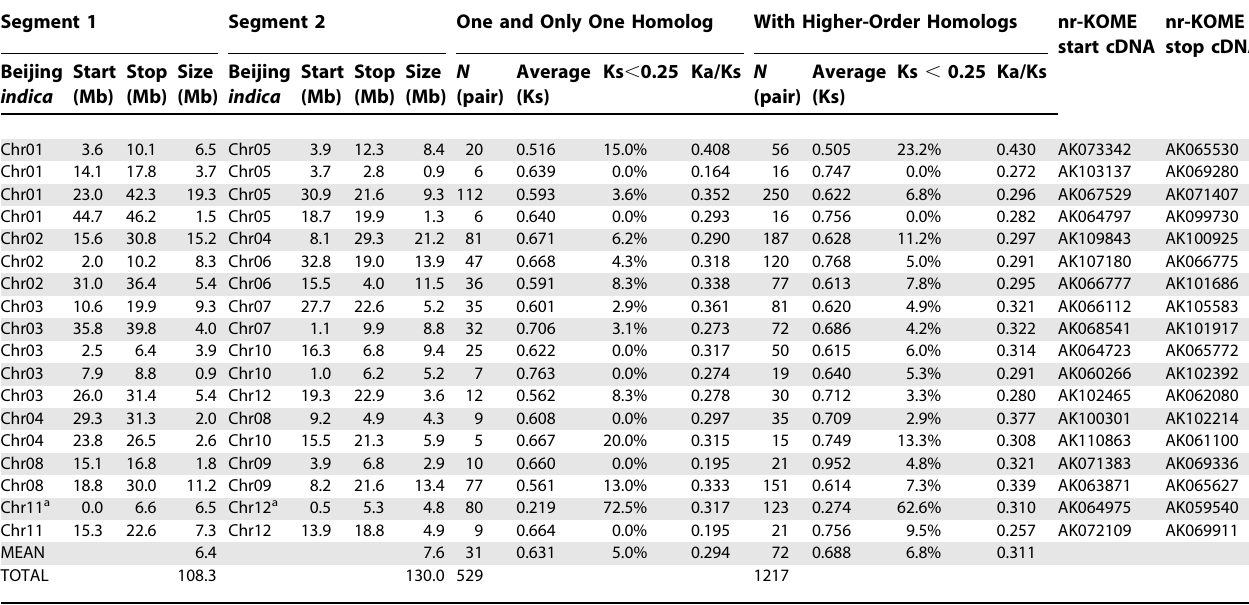
Table 6. Summary of Duplicated Segments in the Beijing indica Assembly Segment 1 Segment 2 One and Only One Homolog With Higher-Order